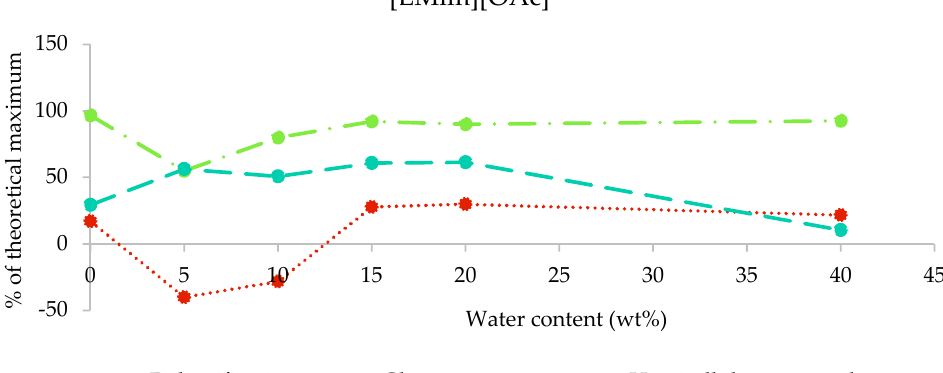
Figure 3. Delignification, glucan recovery, and hemicellulose removal after the pretreatment of poplar with [EMim][OAc] containing 0–40 wt% water for 46 h at 100 °C. The data for the 5 wt% and 10 wt% water samples are not reliable due to residual ionic liquid interfering with the compositional analysis procedure, as explained in Section 2.3.1.